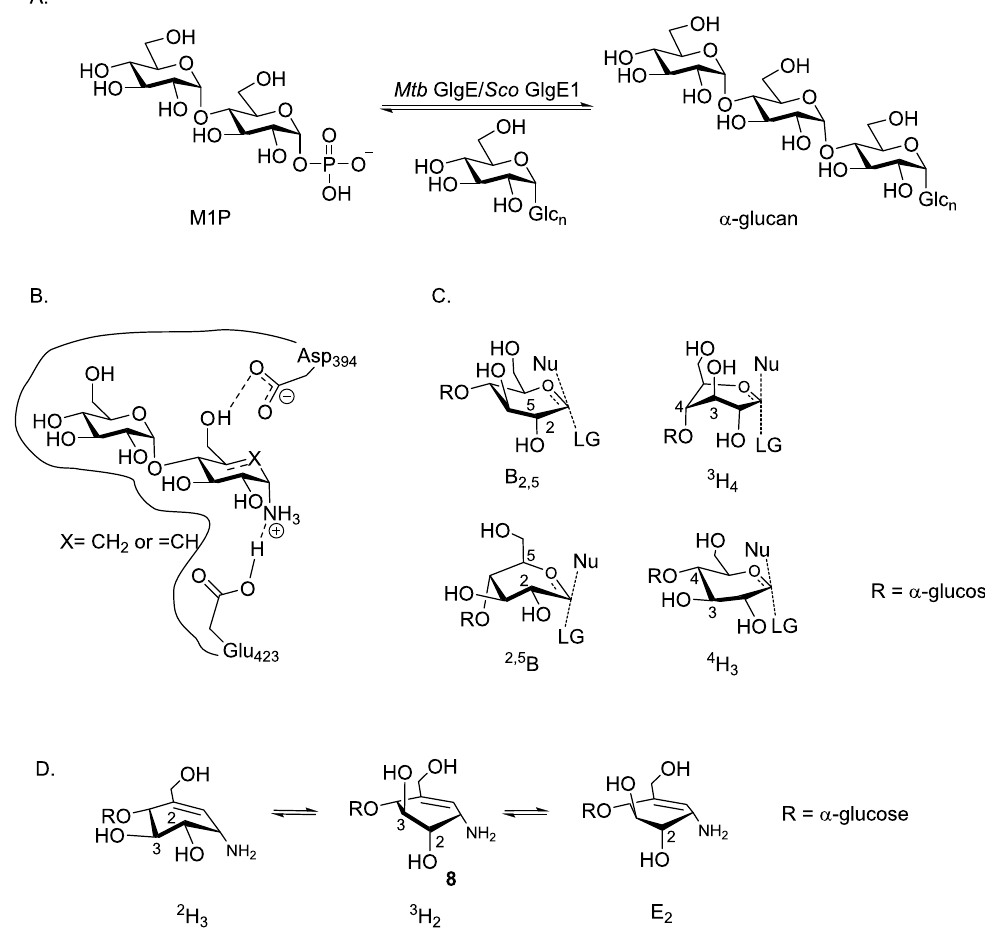
Figure 2. ( A ) Mtb GlgE/ Sco GlgE1 catalyzed glycosylation of α-1,4 glucan with M1P. ( B ) Proposed Sco GlgE1- V279S/ 7 and Sco GlgE1-V279S/ 8 complex coulombic interactions. ( C ) B 2,5 , 2,5 B, 4 H 3 , and 3 H 4 C5–O5–C1–C2 planar TS conformations commonly invoked for GH. ( D ) Possible conformations of the cyclohexene fragment of 8